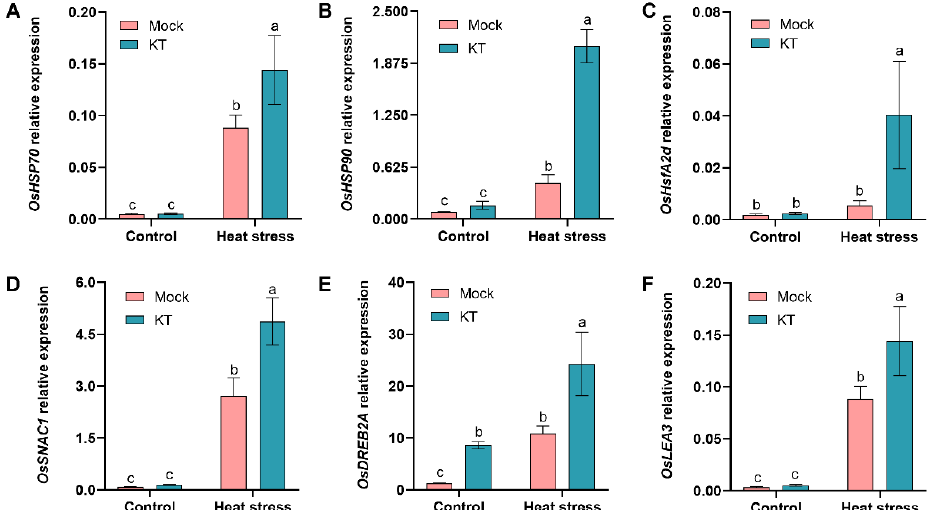
Figure 5. Relative expression of heat-tolerance and heat-defense-related genes in 10 − 9 M KT under heat stress. For qRT-PCR, OsActin1 was used as an internal reference to analyze the relative expression of heat tolerance genes, OsHSP70 ( A ), OsHSP90 ( B ), and OsHsfA2d ( C ), and heat-defense-related genes, OsSNAC1 ( D ), OsDREB2A ( E ), and OsLEA3 ( F ). Data are means ± SD. Different lowercase letters show significant differences among treatments analyzed by one-way ANOVA comparison test (n = 3, p < 0.05).